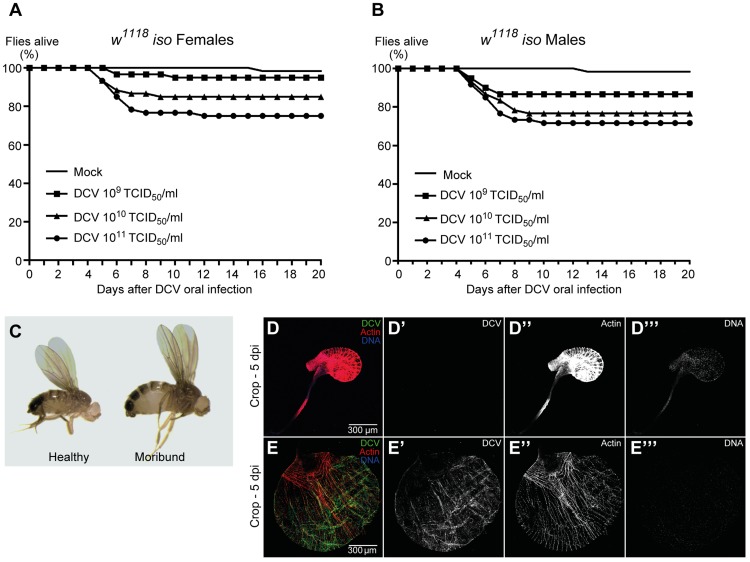
DCV oral infection can cause lethal infections.(A and B) Survival of adult flies after DCV oral infection. Sixty w1118 iso females (A) or males (B), 3–6 days-old flies were orally infected with DCV (109, 1010, or 1011 TCID50/ml) or buffer (Mock), and the survival was monitored daily. Three independent experiments were performed, with similar results. Survival data of both genders and the three experiments were analysed together using the Cox proportional hazard mixed effect model and observed that dose is a highly significant factor (p<0.0001). (C–E) Flies were infected with DCV at 1011 TCID50/ml. (C) After DCV oral infection moribund flies become inflated while challenged but healthy-looking flies do not. (D–E) Moribund flies (E) exhibit an oversized and overinflated crop when compared with challenged healthy-looking flies (D). In moribund flies crop muscle cells are infected with DCV (E). Adult male crops were immunostained with antibody against DCV (green), actin marked with phalloidin (red) and DNA marked with TOTO3 (blue).